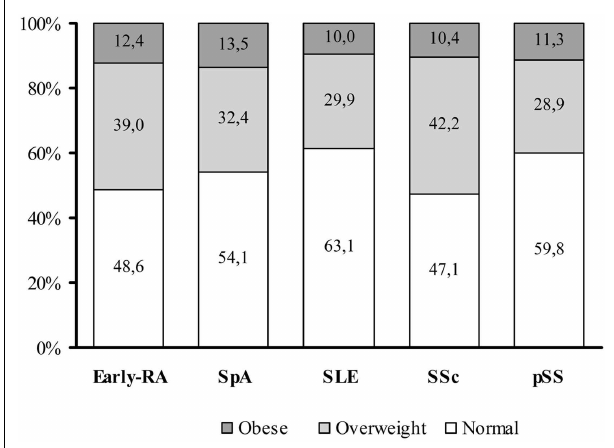
FIGURE 1 | Distribution of BMI categories among an Italian cohort of adult autoimmune disease patients . In our tertiary referral centre, the prevalence of overweight [defined according to theWHO International standards as a body mass index (BMI) of 25–29.9] or obesity (BMI ≥ 30) is similar between the different autoimmune disease categories.The graph summarized data from an early-rheumatoid arthritis (early-RA) cohort of patients ( N = 401, 76.3% female, mean age: 54.6 ± 14.0years, mean BMI of 25.3 ± 4.4Kg/m 2 ), a Spondyloarthritis (SpA) cohort ( N = 220, 30.6% female, mean age: 39.5 ± 11.8years, mean BMI of 25.1 ± 4.4Kg/m 2 ), a Systemic Lupus Erythematosus (SLE) cohort (506 patients, 90.3% female, mean age: 44.1 ± 14.8years, mean BMI of 24.0 ± 4.6Kg/m 2 ), a Systemic Sclerosis (SSc) cohort (442 patients, 88.2% female, mean age: 58.5 ± 14.2years, mean BMI of 24.4 ± 4.8Kg/m 2 ), and a primary Sjogren Syndrome (pSS) cohort (204 patients, 96.1% female, mean age: 56.4 ± 14.3years, mean BMI of 24.3 ± 4.3Kg/m 2 ) (10). Data are reported as percentage (%) of normal weight, overweight, and obesity in the different